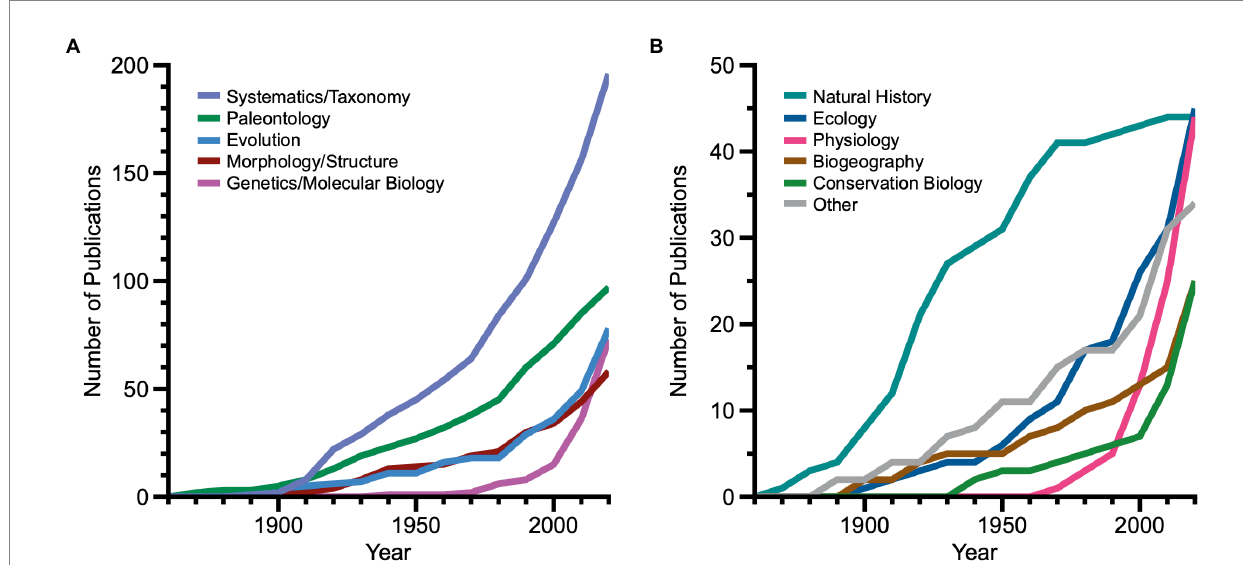
FIGURE 7 Line graphs showing relative changes in the primary biological subject area for each of 719 publications that designate living fossil entities from 1860 to 2020. Note that more than one entity may be noted in a given publication. (A) Five primary subject areas that each exceed 50 publications. (B) Six primary subject areas with fewer than 50 publications each. Note the different scales for numbers of publications in the two